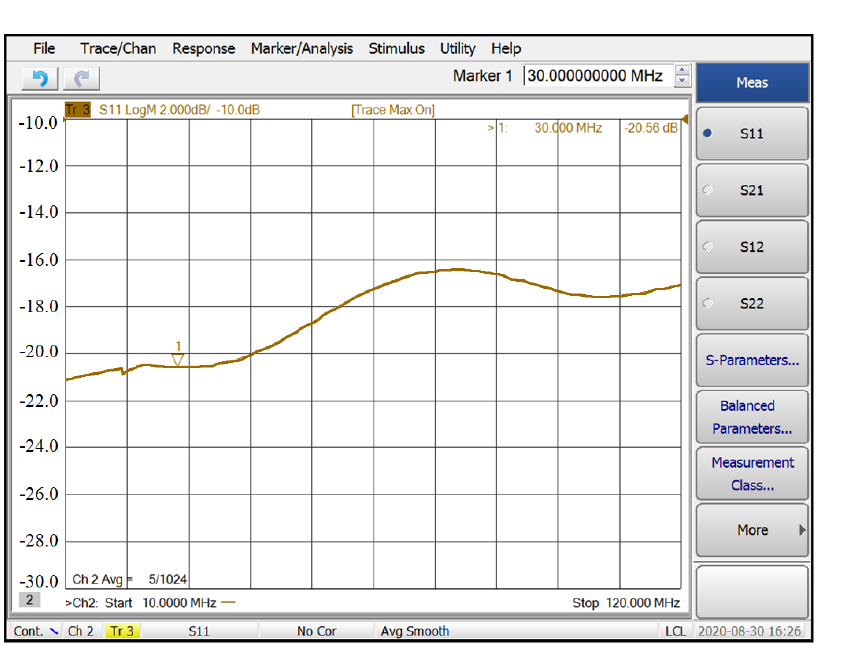
Figure 16. ( a ) Measurements setup; ( b ) S 11 and frequency response measurement; and ( c ) noise den- sity and THD measurement.